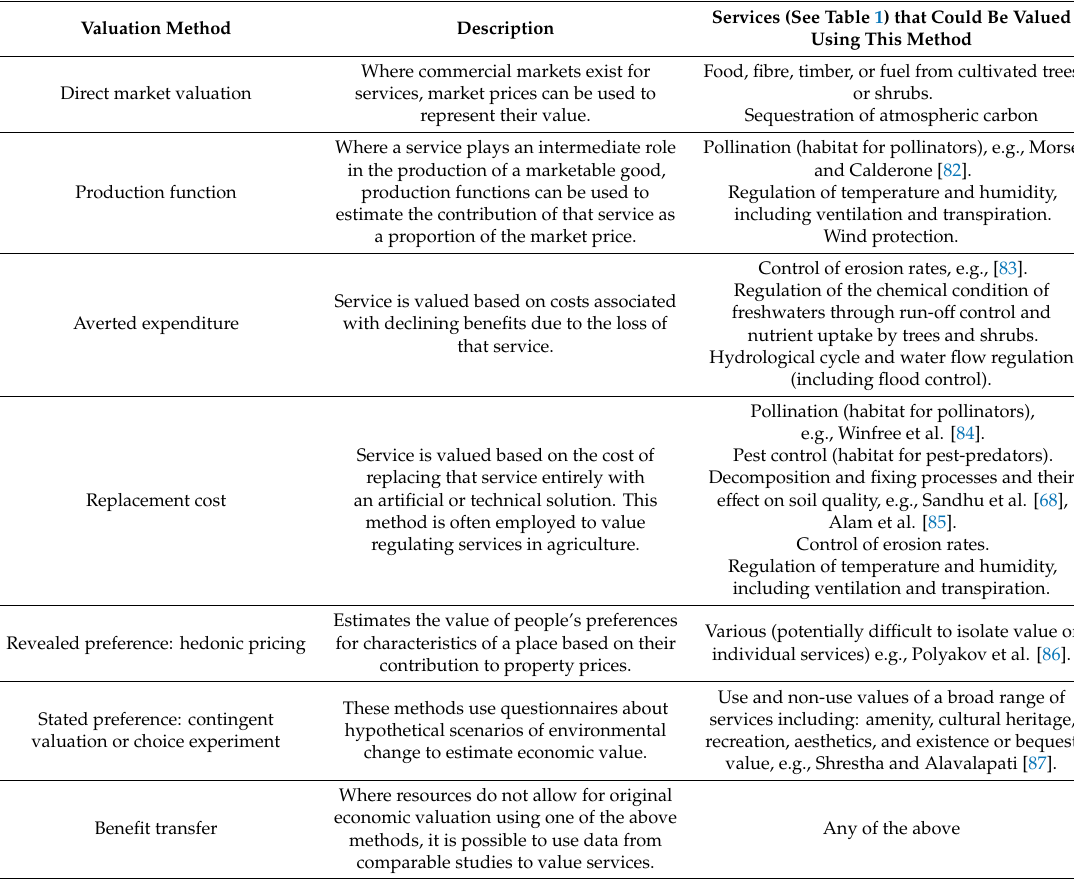
Table 2. Methods for valuing ecosystem services provided by agroforestry assets at the farm scale with examples of how they might be applied if the farmer is considered the primary